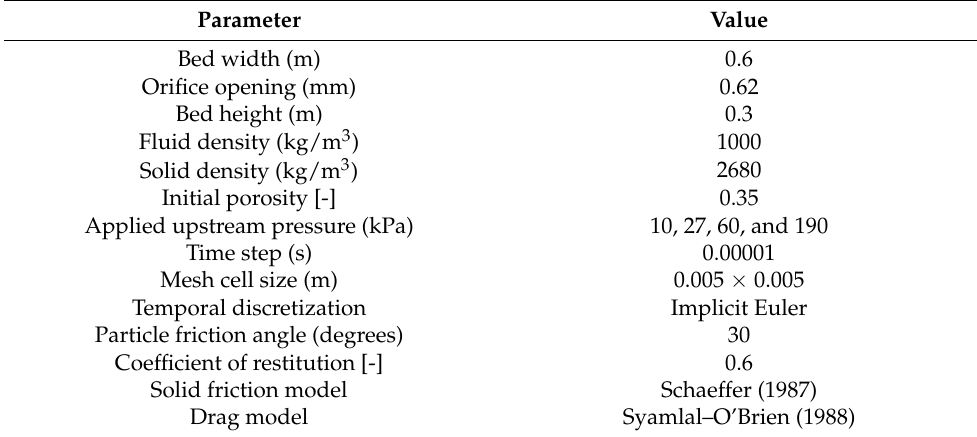
Table 2. Summary of the experimental parameters